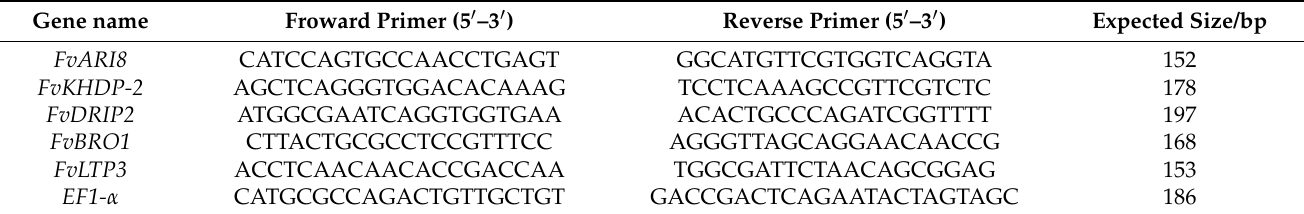
Table 4. qRT-PCR primer sequence of imprinted gene of F. vesca .